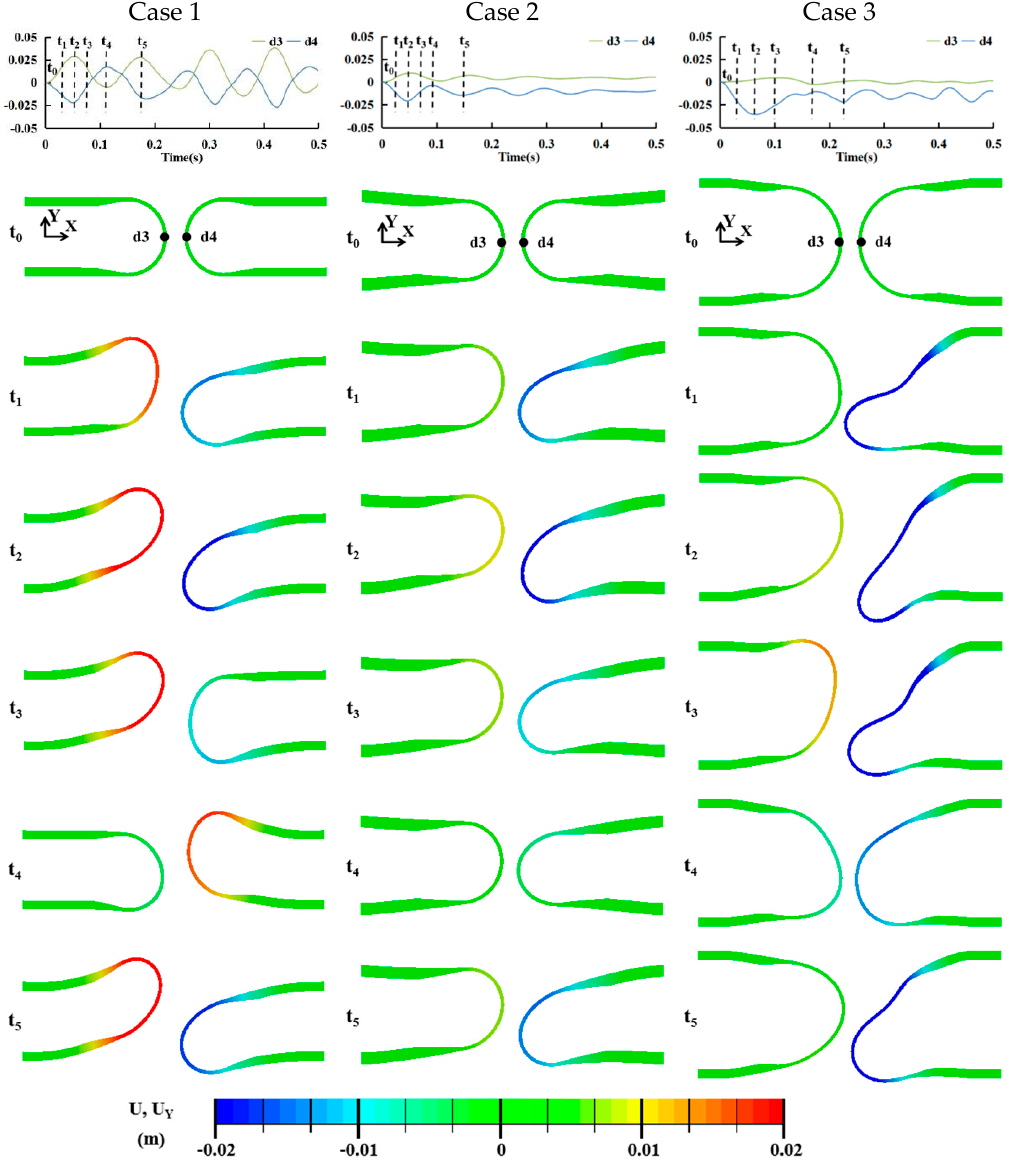
Figure 17. Comparison of typical deformation forms for the three schemes in the initial vibration stage.